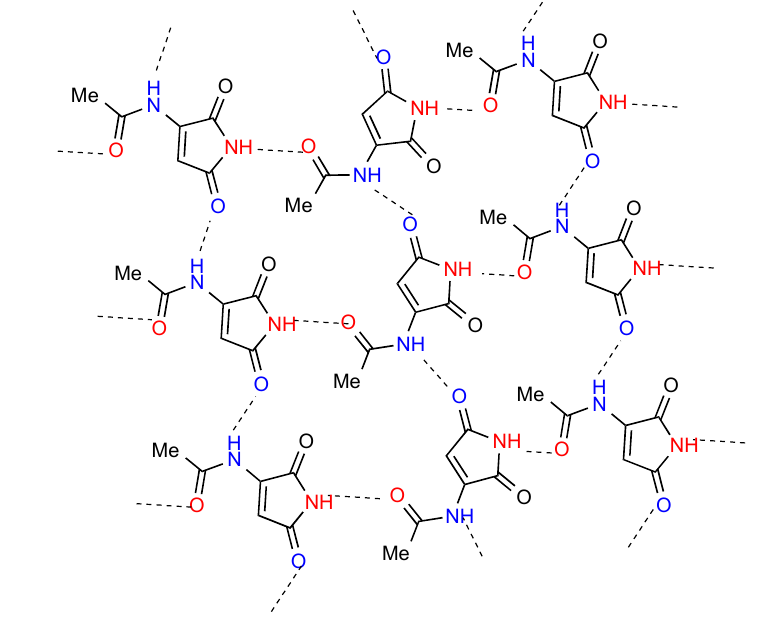
Figure 4. Structure observed for compound 4.